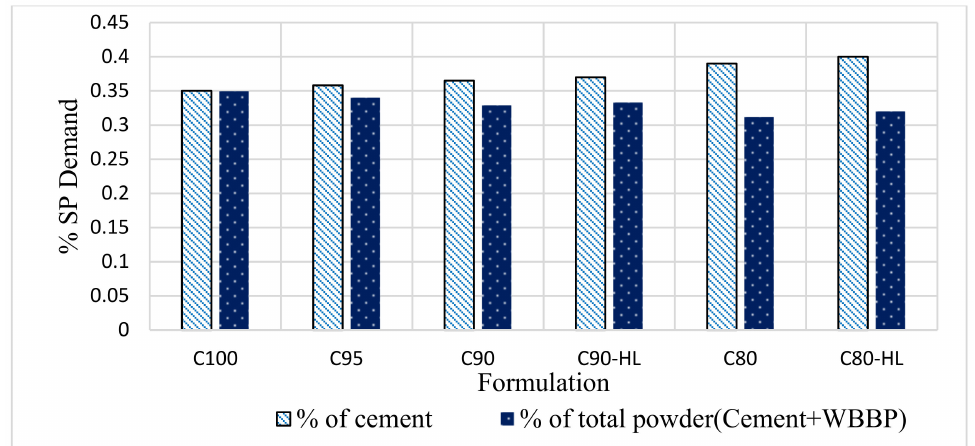
Figure 7. Superplasticizer demand of self-compacting paste